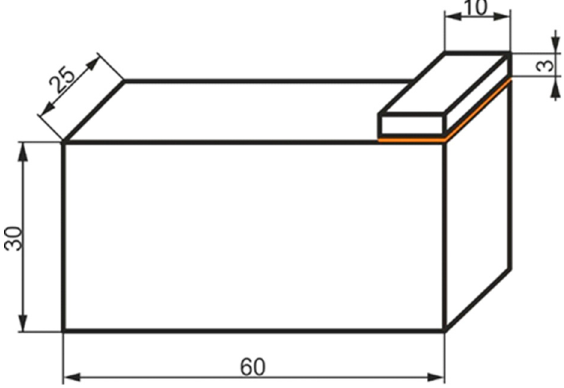
Figure 1. Sample used in impact strength tests. All dimensions in (mm).